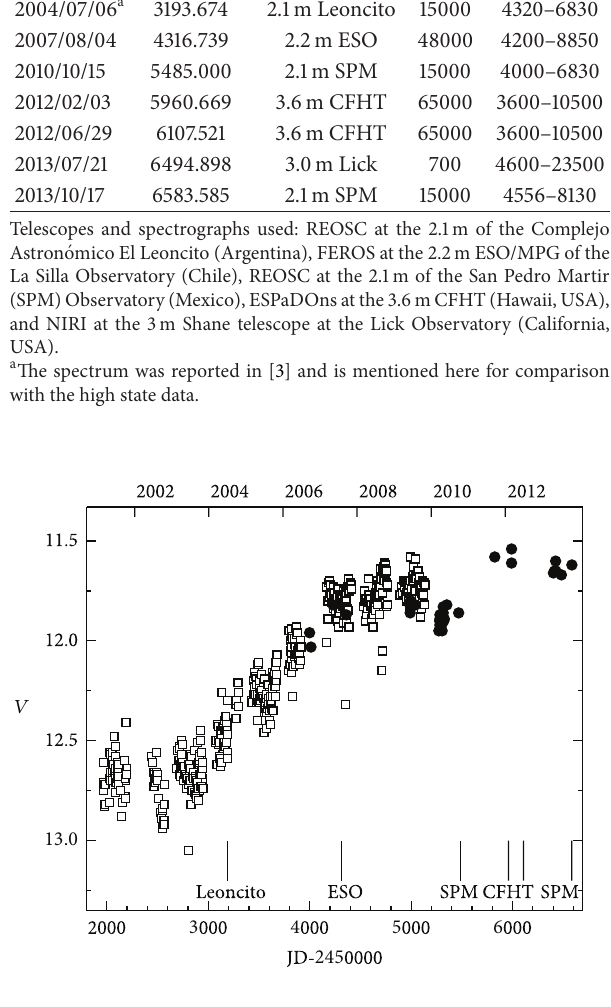
Figure 1: 𝑉 -band light curve of MWC 930 in 2001–2013. Open squares show data from ASAS-3, and filled circles show our PROMPT data. Short lines show times of the spectral observations and the observatory name. The upper horizontal axis tick marks show beginning time of the indicated